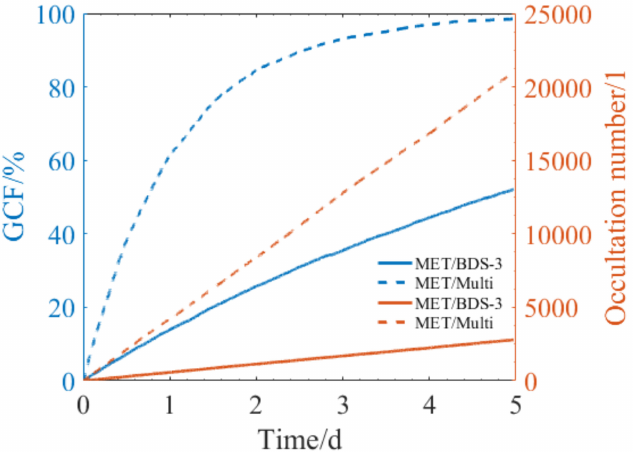
Figure 4. GNSS RO number and global coverage fraction trend for MET/BDS − 3 and MET/multi − GNSS RO